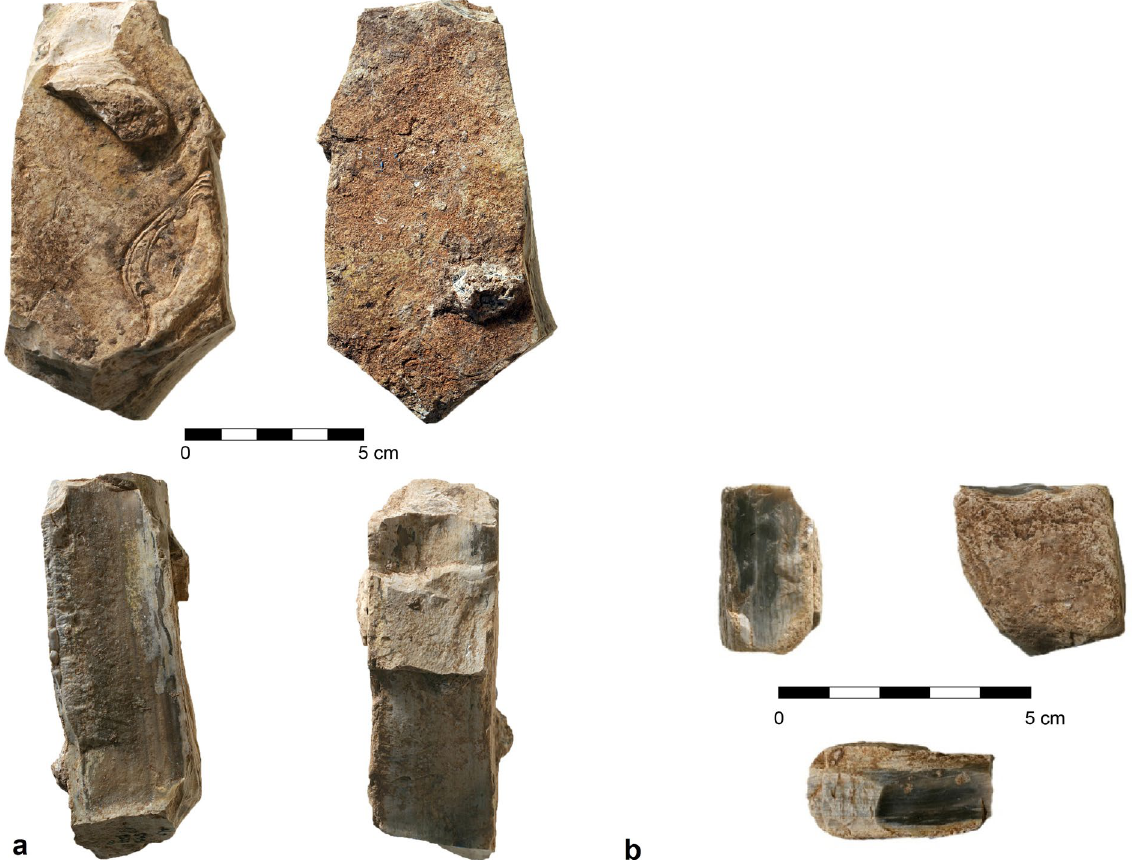
Figure 8. (a-b): flat quadrate slabs suitable for the production of laminar